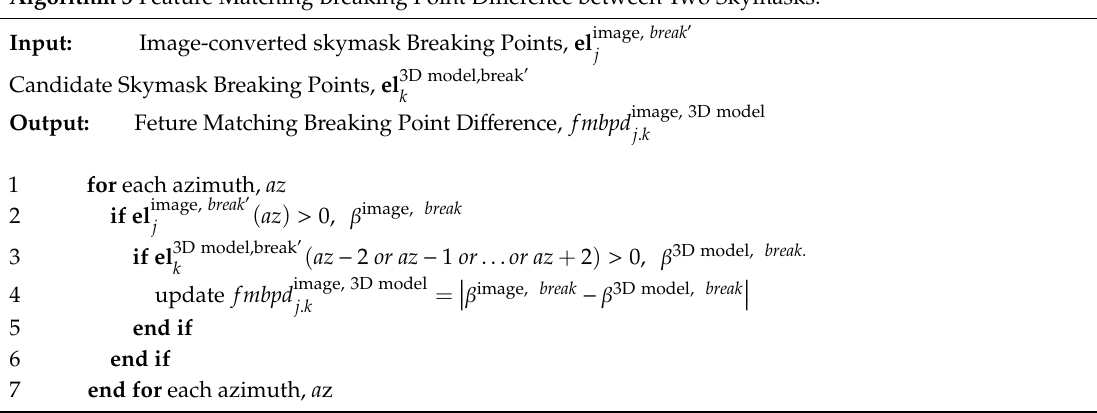
Algorithm 3 Feature Matching Breaking Point Di ff erence between Two